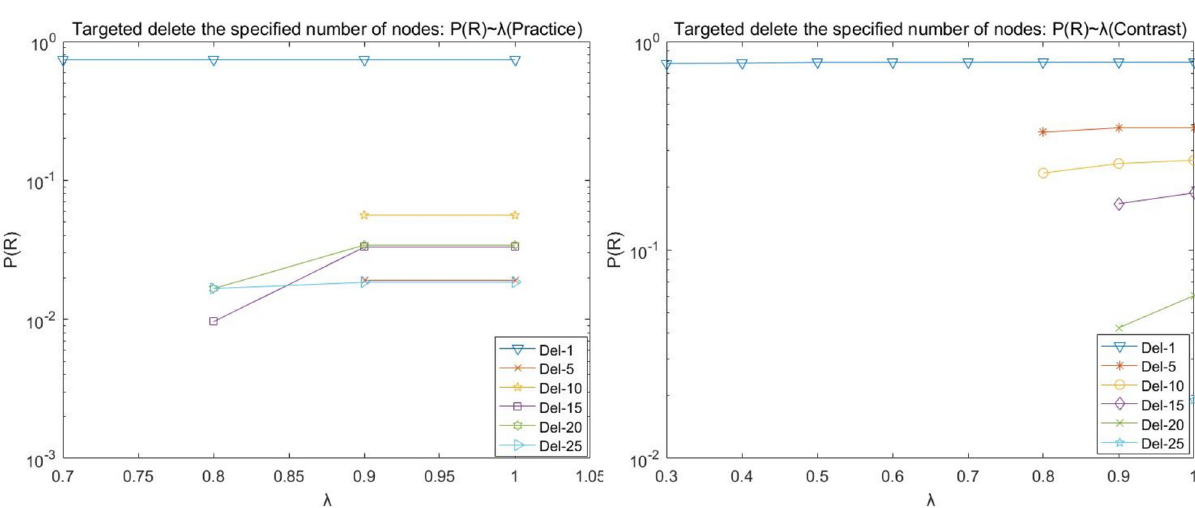
decreases, and the transaction volume transmitted downstream by the upstream nodes increases, while the maximum load of the downstream nodes is not enough to carry the trans- action volume of the upstream nodes, and thus the phenomenon of node overload and failure occurs; when the load factor continues to increase until the maximum load of the downstream nodes is enough to carry the transaction volume of the upstream nodes, the network reaches better robustness. (C)The (Contrast) network is not strong due to more nodes in the intermediate level. It requires a larger load factor to not experience paralysis due to the cascading phenomenon of the network once the number of target nodes is five or 10 when removed. The P(N), P(L), P (R), and P(Q) fold diagrams of the network (Contrast) do not show disruptions.